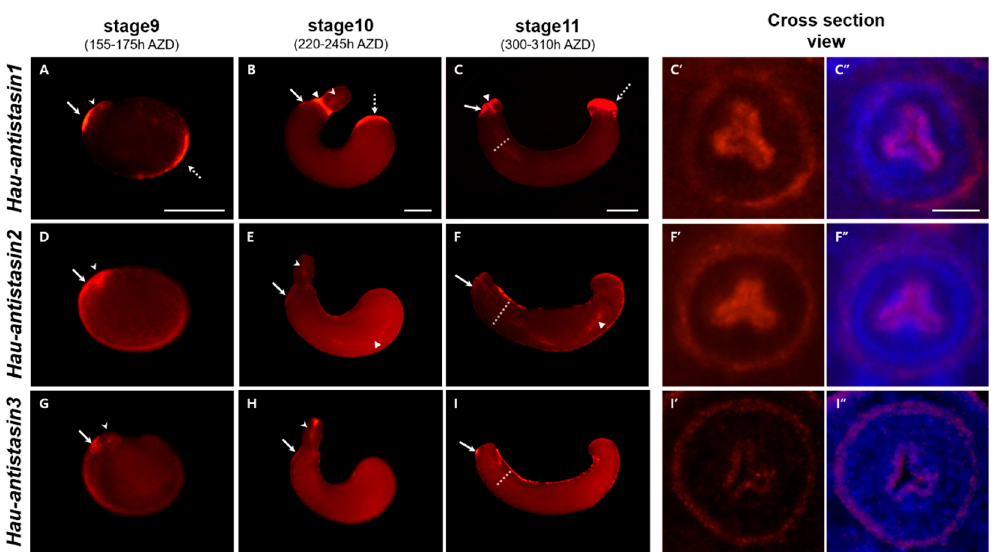
Figure 3. Spatial expression of Hau-antistasin . In all panels, the anterior is to the left, dorsal is to the top. ( A – C ) Lateral view of Hau-antistasin1 expressed embryo. At stage 9, Hau-antistasin1 is expressed in prostomium (white arrowhead), adhesion epithelium to maternal venter (white arrow), and posterior germinal plate (white dot arrow). At stage 10, Hau-antistasin1 is expressed in the external proboscis, adhesion epithelium (white arrow), proboscis cavity (white arrowhead), boundary of eversion furrow (white triangle), and posterior body (white dot arrow). At stage 11, Hau-antistasin1 is expressed in the proboscis chamber (white triangle), anterior sucker epithelium (white arrow), and posterior sucker precursor (white dot arrow). ( C’ , C” ) To confirm the exact expression region in the proboscis, we dissected the proboscis at stage 11 (white dot line in C). Hau-antistasin1 is expressed in the outer layer of proboscis and proboscis cavity. ( D – F ) At stage 9, Hau-antistasin2 is expressed in the prostomium (white arrowhead), adhesion epithelium to maternal venter (white arrow), visceral muscle precursor and whole germinal plate. At stage 10, Hau-antistasin2 is expressed in the proboscis cavity (white arrowhead), adhesion epithelium (white arrow), and visceral muscle (white triangle). At stage 11, Hau-antistasin2 persisted in the anterior sucker epithelium (white arrow), proboscis cavity, external layer of the proboscis, and gut boundary (white triangle). ( G – I ) Hau-antistasin3 is expressed in the adhesion region (white arrow) and prostomium (white arrowhead) at stage9. At stage 10, Hau-antistasin3 is expressed in the proboscis cavity (white arrowhead), and adhesion epithelium (white arrow). At stage 11, Hau-antistasin3 is expressed in the anterior sucker epithelium (white arrow). ( F’ , F” , I ’, I” ) Cross sections of Hau-antistasin2 and Hau-antistasin3 show expression similar to Hau-antistasin1 . Scale bar: A–C = 200 μ m; C” = 20 μ m.